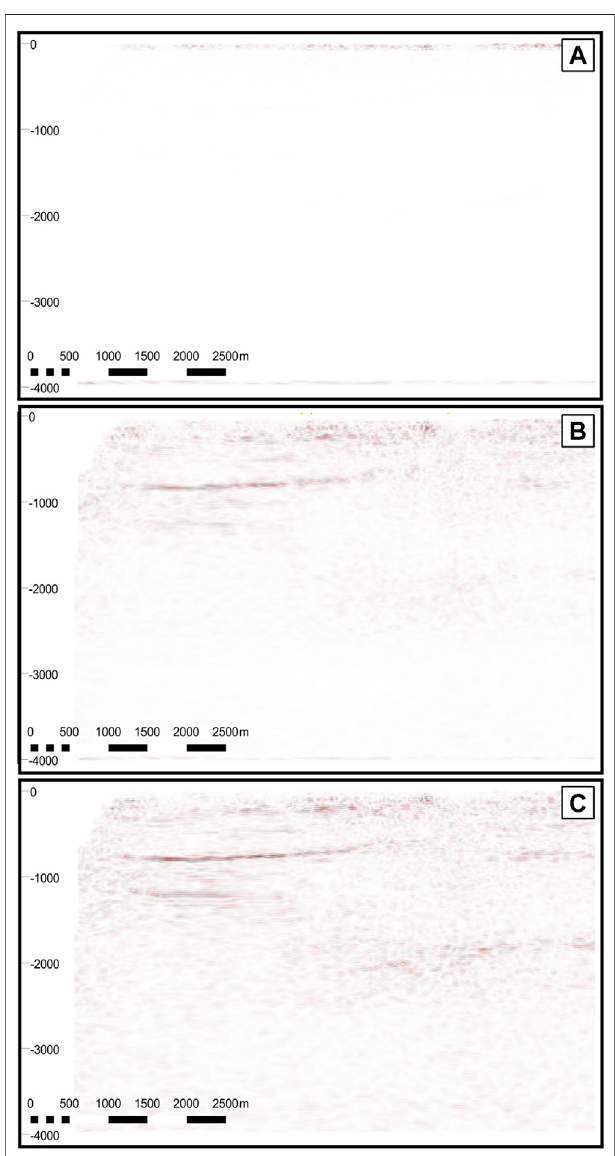
FIGURE 12 | Difference between the original seismic data and a) low pass fi lter cut at 90 Hz; b) low pass fi lter cut at 60 Hz and c) low pass fi lter cut at 40 Hz. The section is orientated E-W (XL